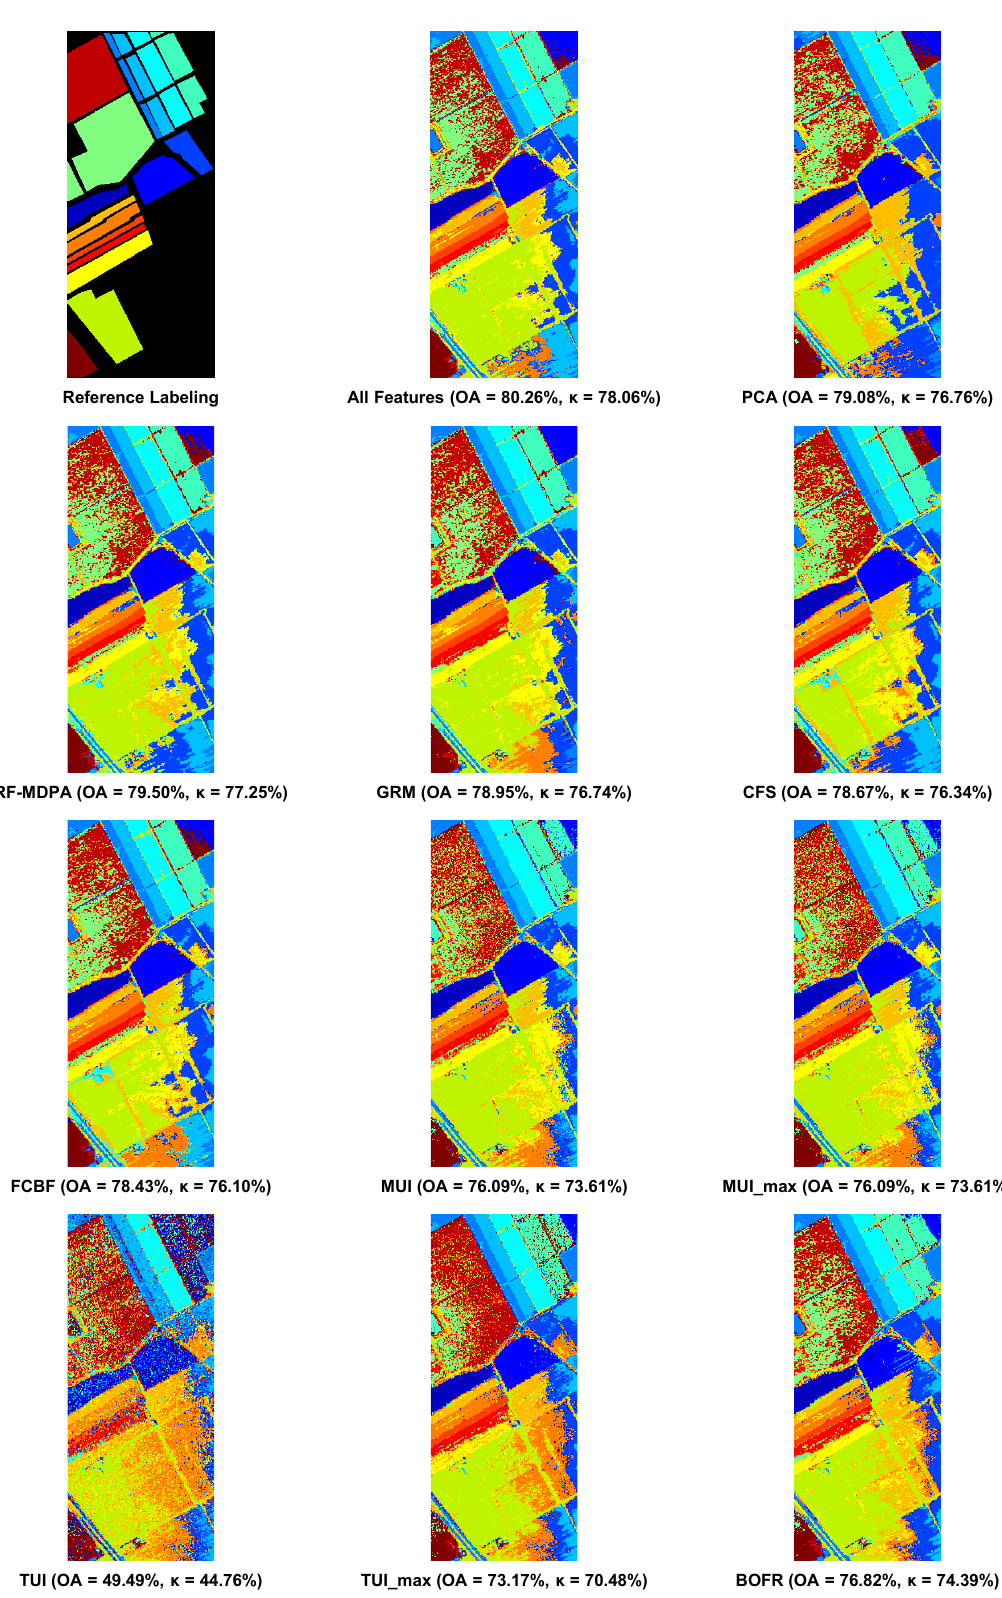
Figure 12. Classified scene for the Salinas dataset when using the RF classifier and different feature sets. The values in brackets refer to the evaluation on the test